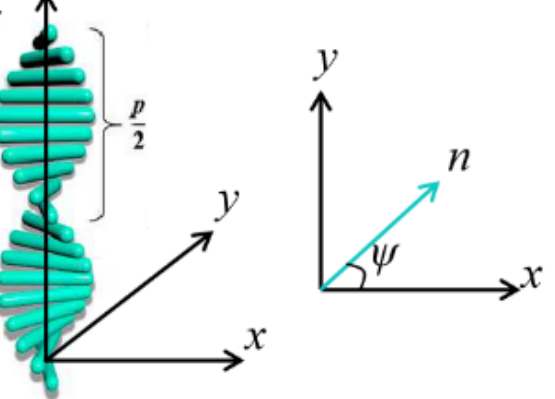
Figure 1. Schematic drawing of a twisting liquid crystal (LC) structure. Equation (1) represents the LC director field: